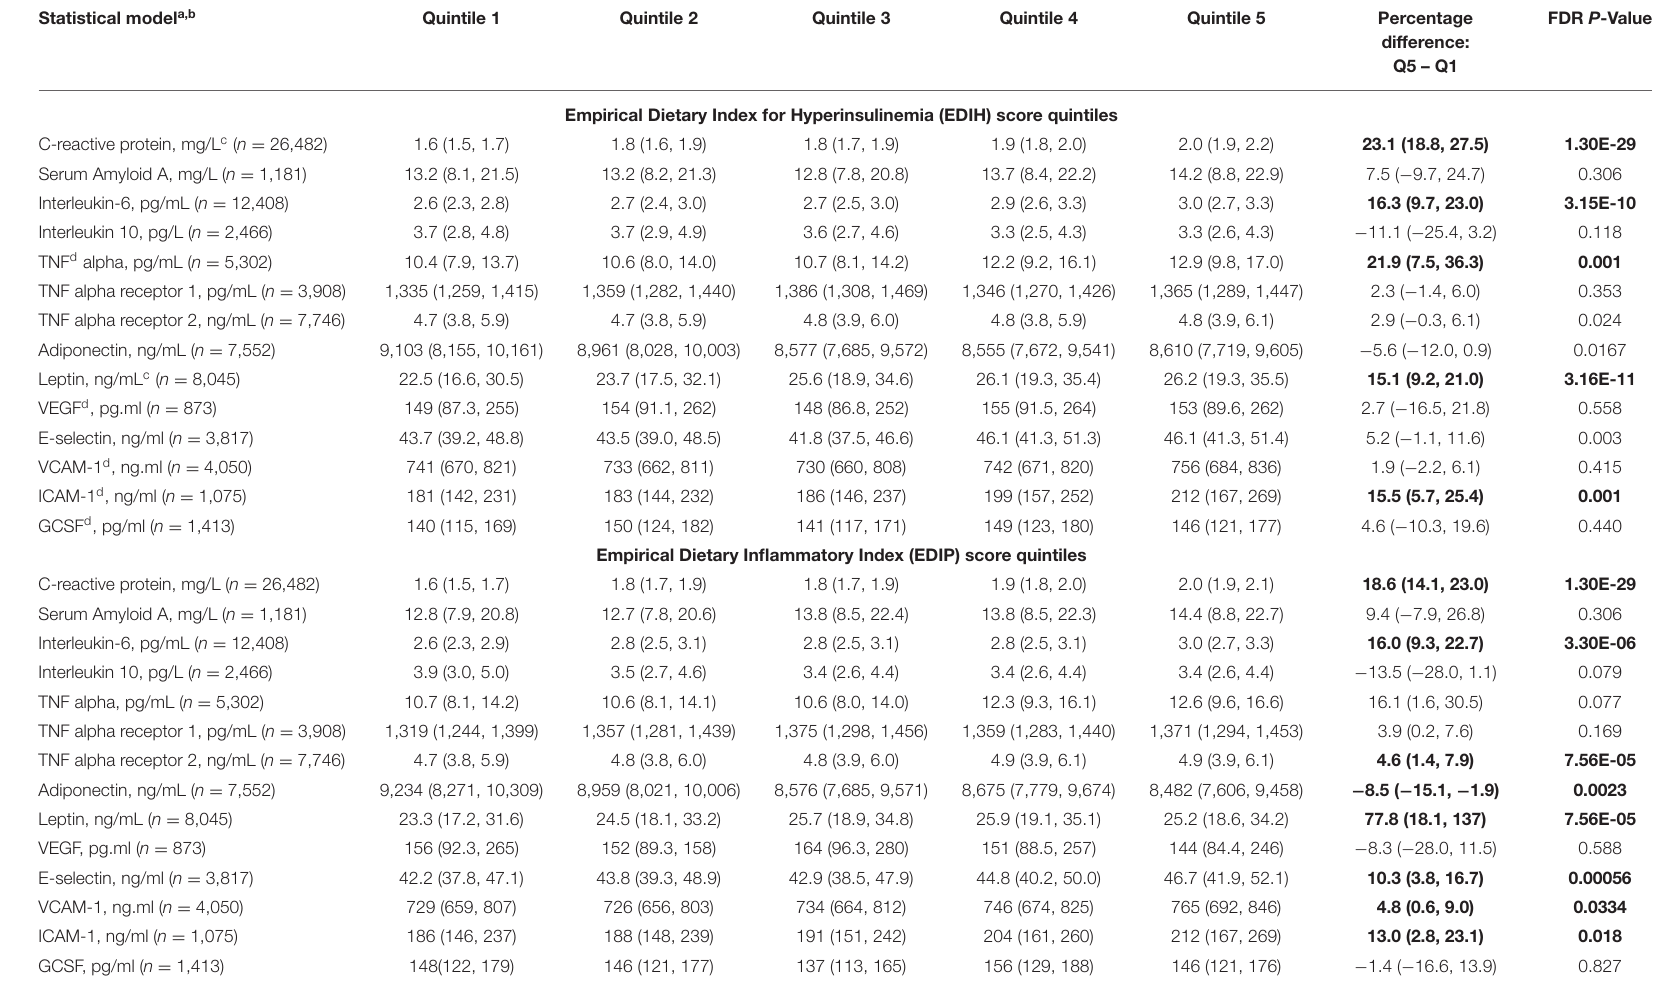
FDR P -Value difference: Q5 – Q1